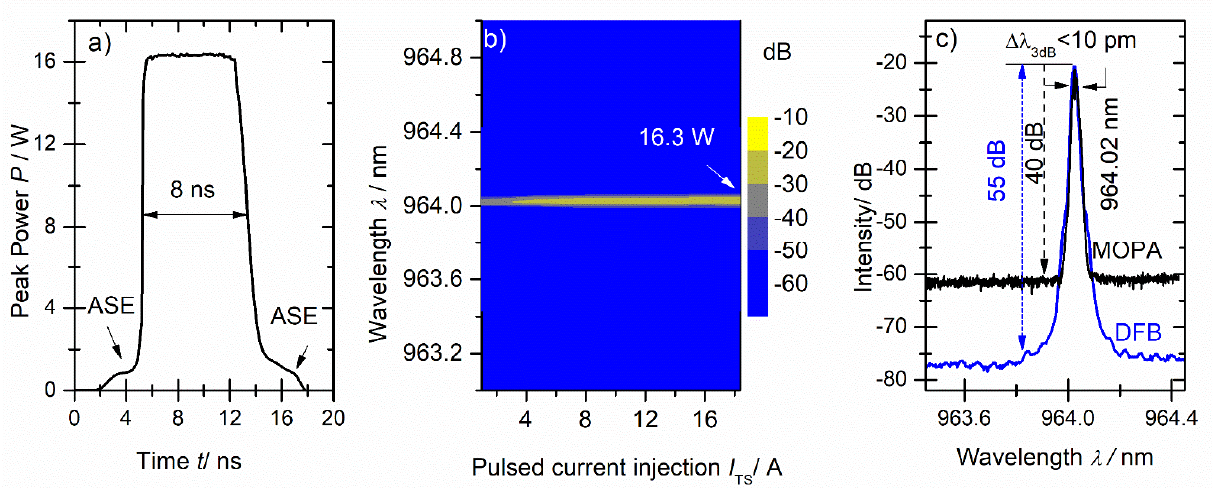
Figure 5. ( a ) Temporal behavior of the optical power emitted by the MOPA system at a seed wavelength of 964.02 nm, ( I G1 = 130 mA, I G2 = 0 mA). ( b ) Color-scale mapping of the time-averaged optical spectrum of the MOPA in dependence of the amplitude of the current pulses injected into the TS for a fixed DFB laser current of I G1 = 130 mA, I G2 = 0 mA. ( c ) Comparison between the optical spectra of the DFB laser and the MOPA system for I G1 = 130 mA, I G2 = 0 mA and I TS = 18.4 A.